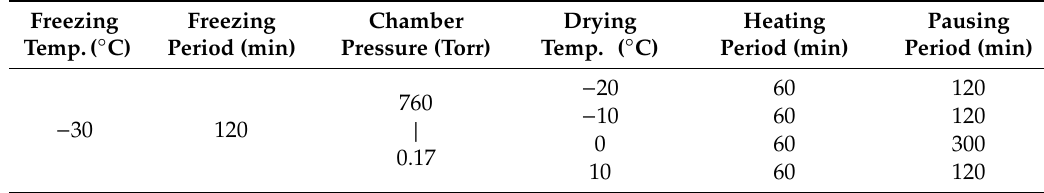
Table 1. The typical procedure used for the freeze-drying